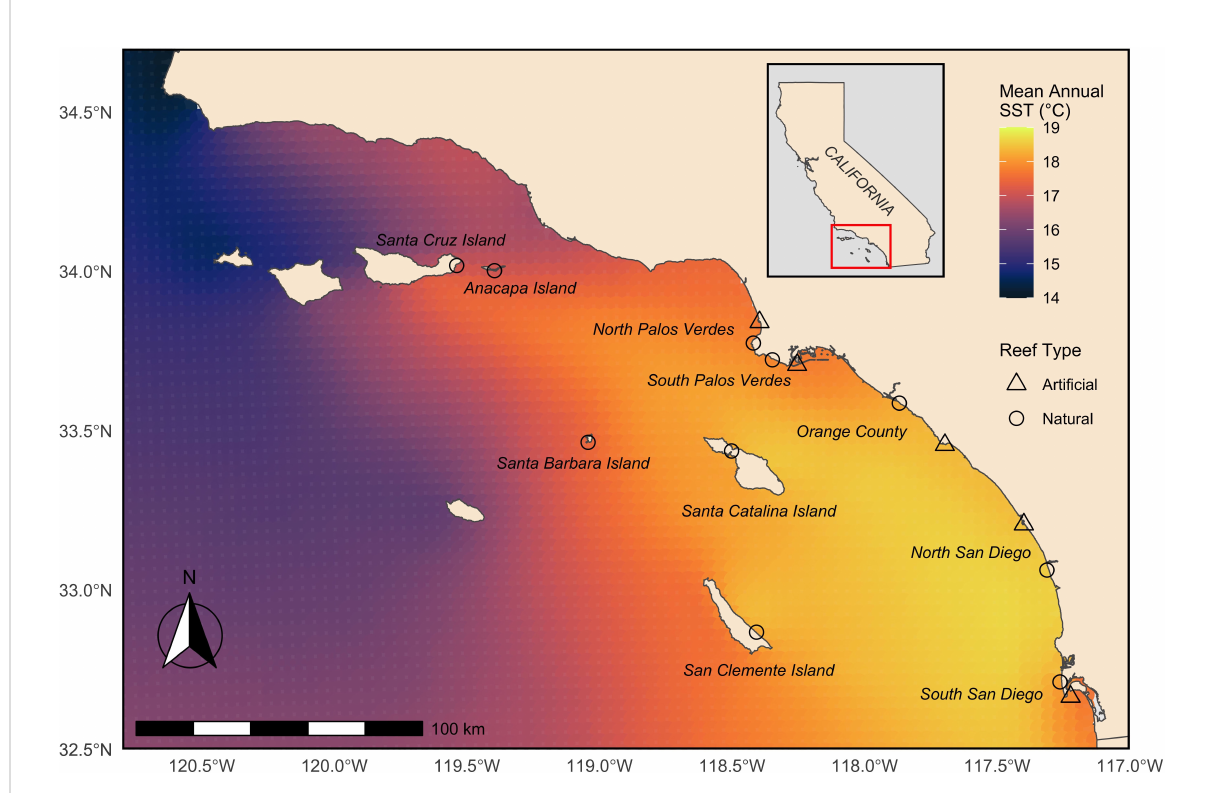
FIGURE 1 Map of sampled Garibaldi ( Hypsypops rubicundus) populations (locations) in the Southern California Bight. Reef type is indicated by shape – triangles for arti fi cial rocky reefs (i.e., breakwaters and jetties) and circles for natural rocky reefs. Mean annual sea surface temperature (SST;°C) values for January 2002-December 2018 are from merged 1 km resolution